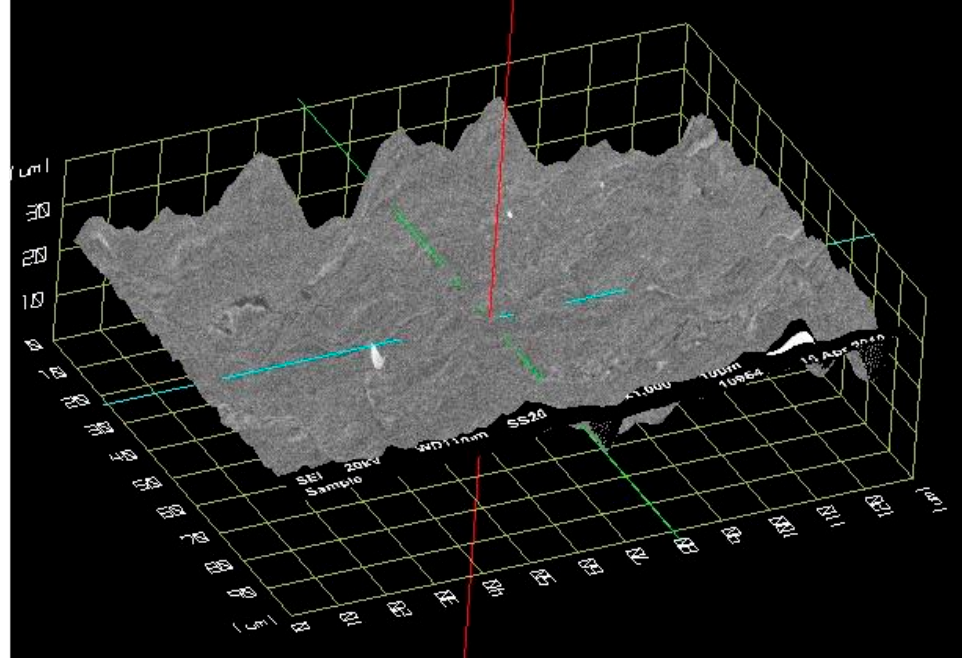
Figure 4. Surface relief of Fe-Cr-Al alloy foil in the initial state.